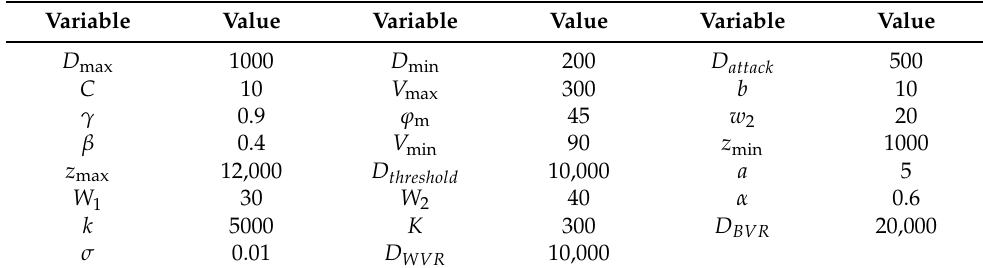
Table 3. Design of the simulation